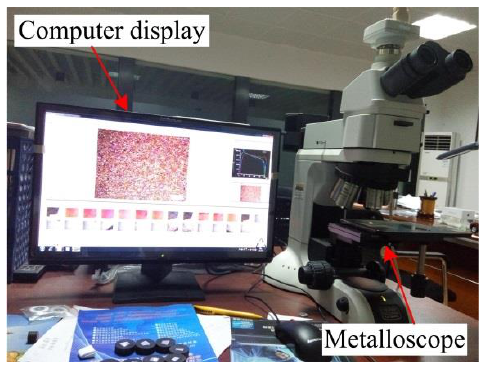
Figure 3. Picture of the optical microscope used in this